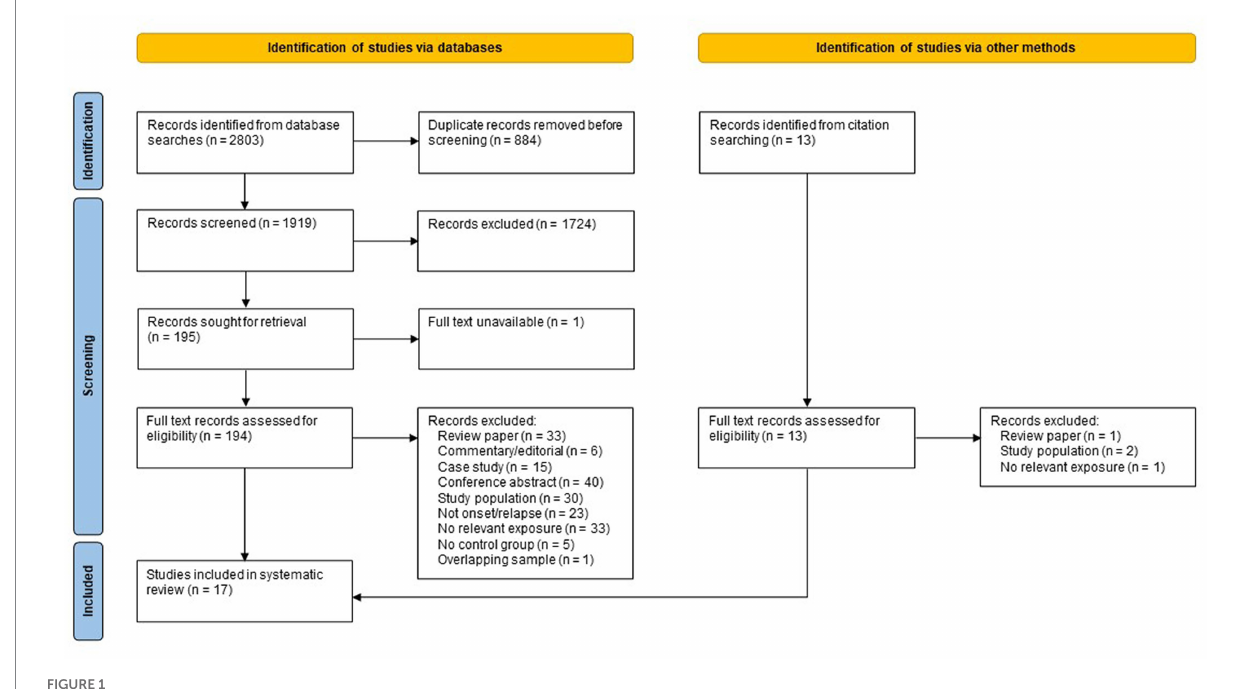
FIGURE 1 PRISMA flow diagram of study